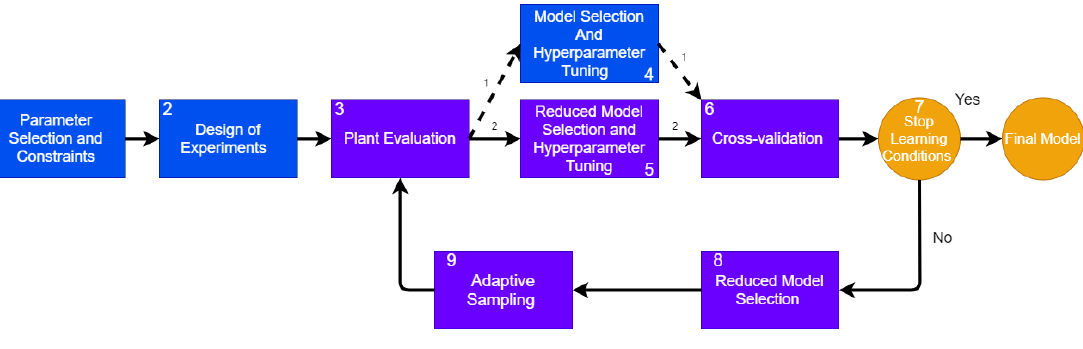
Figure 1. Adaptive Sampling and Automatic Model Selection (ASAMS) general